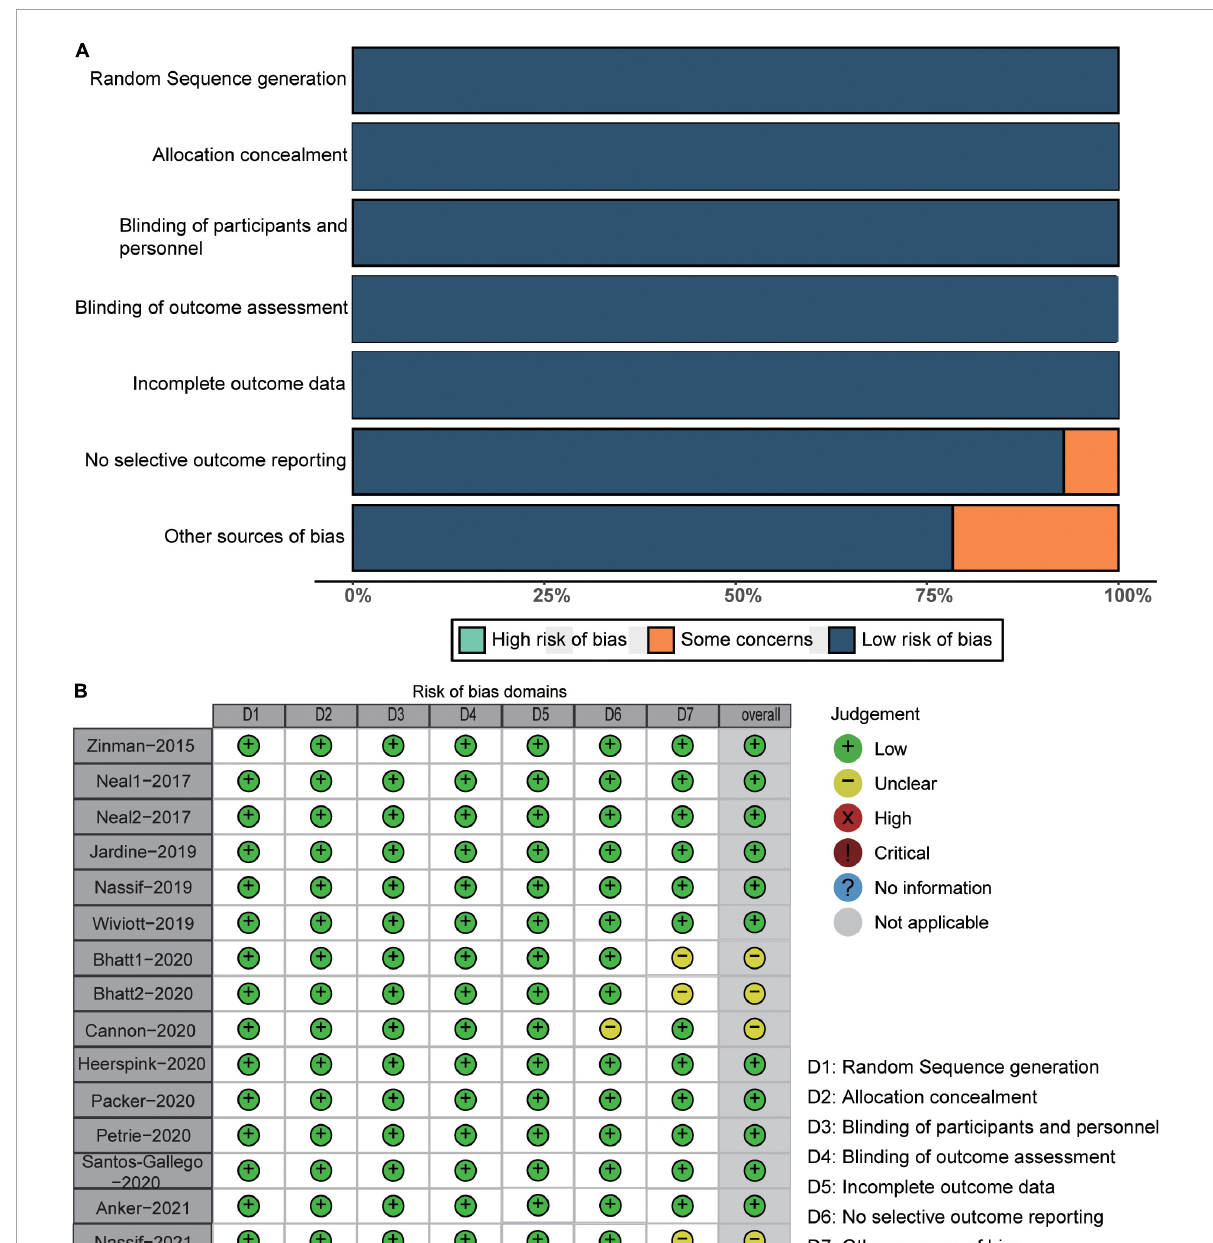
FIGURE2 Risk of bias plot. (A) Risk of bias summary; (B) risks of bias of each included study.